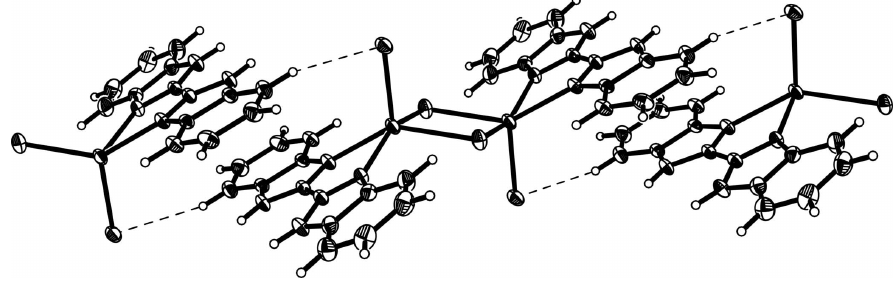
Figure 2 One dimensional chain formed by hydrogen bonds (dashed lines) in the crystal structure of the title